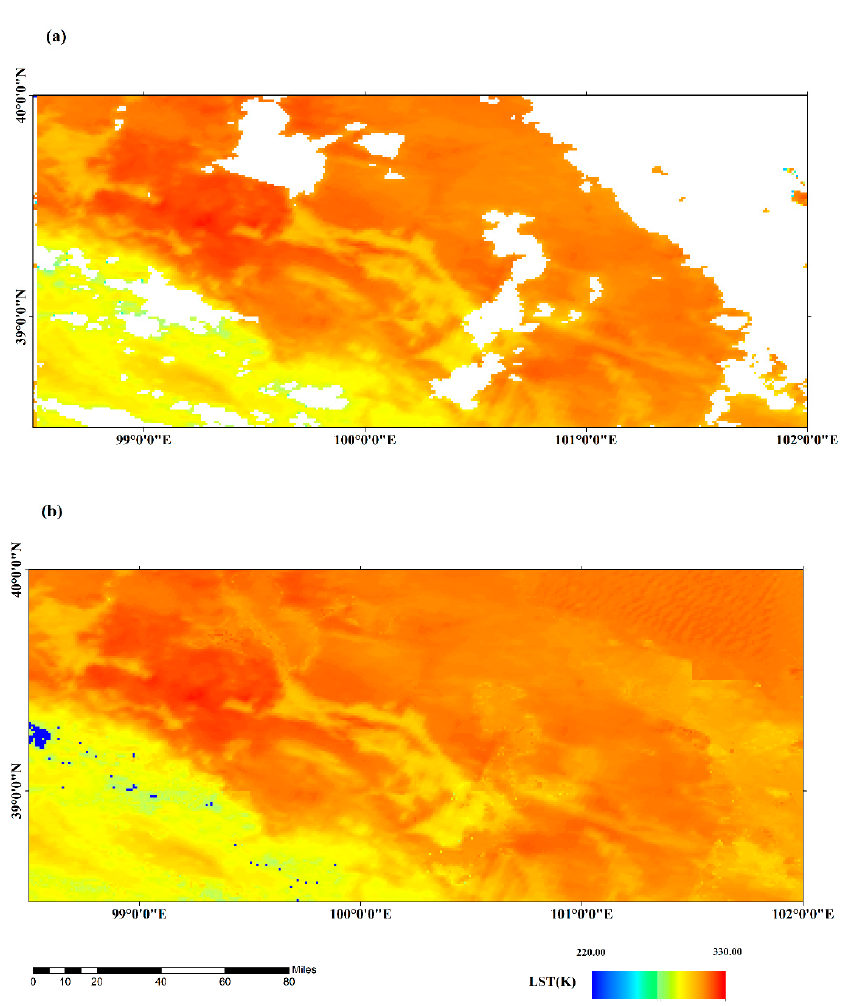
Figure 5. MODIS LST image on 209th, 2009: ( a ) before reconstruction, ( b ) after reconstruction, where LST: land surface temperature.